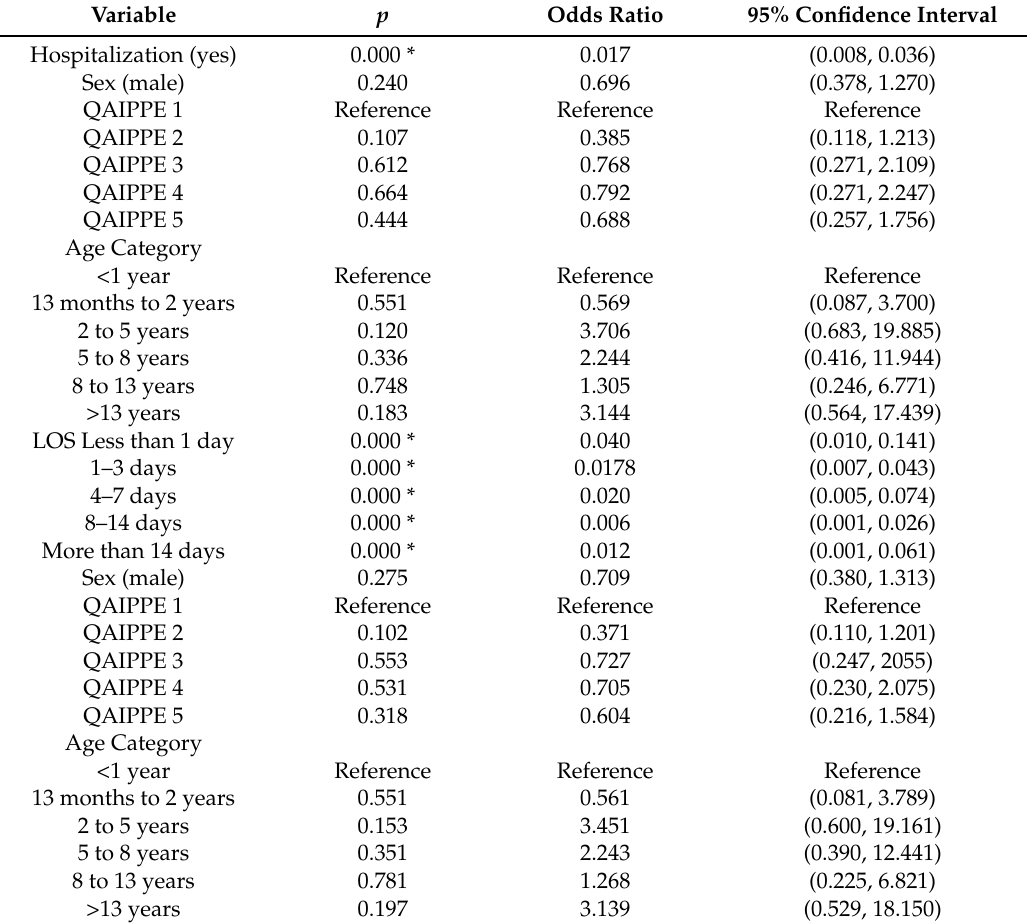
Table 3. Logistic regression model with all covariates.